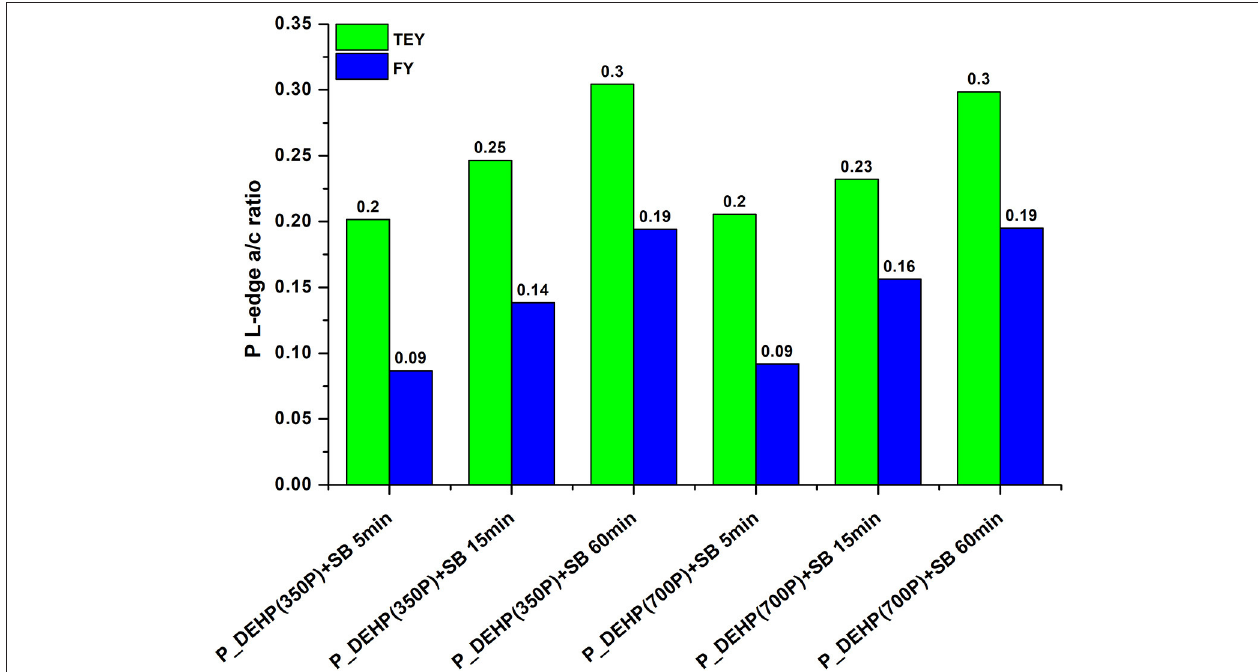
FIGURE 9 | P L-edge a/c ratio measured for tribofilms formed using P_DEHP(350P) + SB and P_DEHP(700P) + SB at 5, 15, and 60min